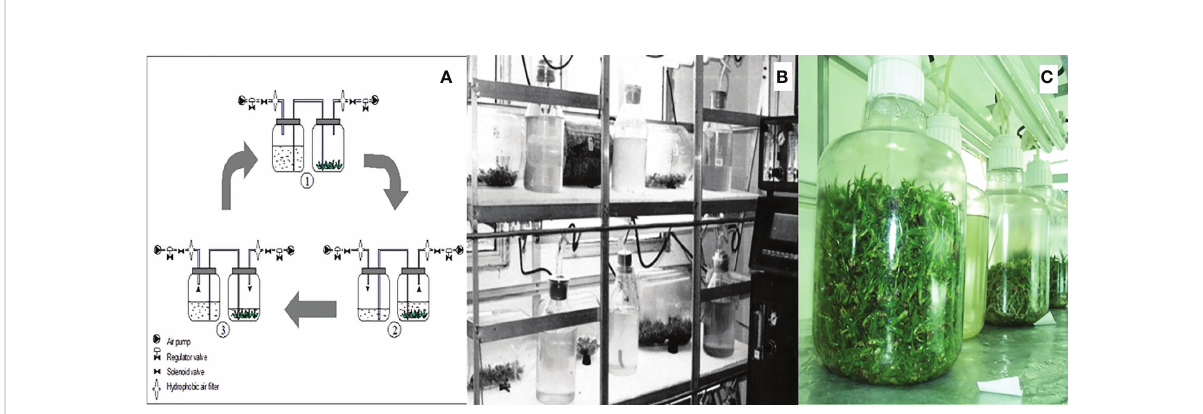
FIGURE 3 (A) Operating cycle of BIT ® : (1) Non-immersed stage, shoots are free-standing on the bottom of the culture vessel, (2) beginning of the immersed, (3) end of the immersed stage. These steps are performed, e.g., every 3h. The air pump and electric valves were under control of a timer. (B) First; (C) and second generation of BIT ® used to pineapple and sugar cane